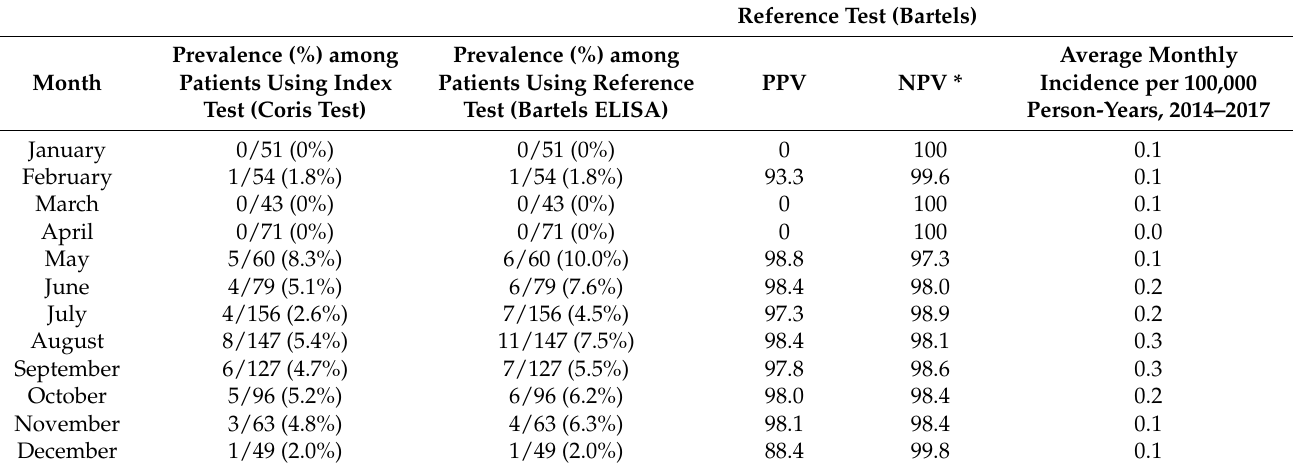
Table 3. The trend Legionella test method for reference for prevalence, PPV, and